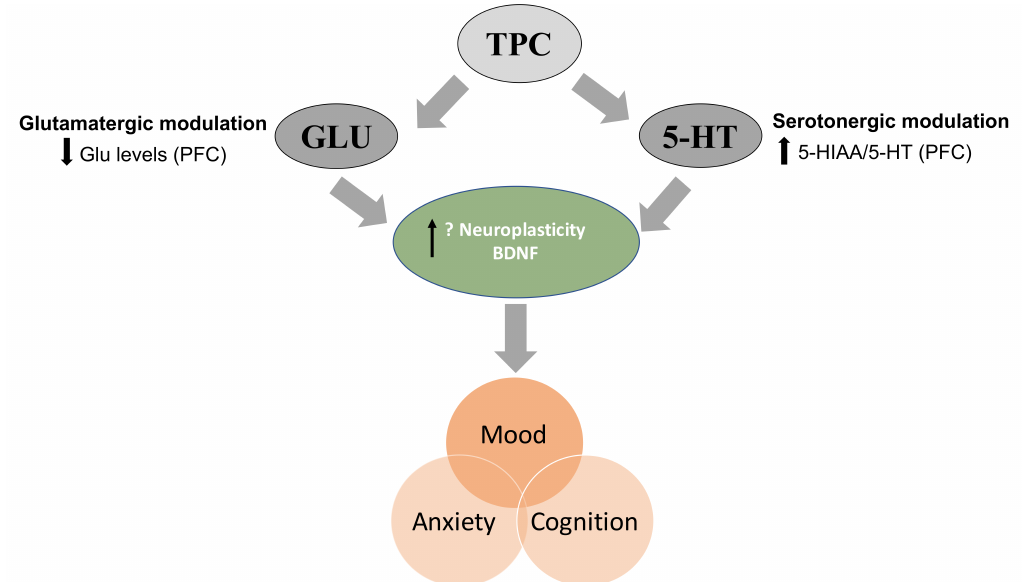
Figure 7. TPC in high doses a ff ects serotonergic and glutamatergic neurotransmission in the PFC